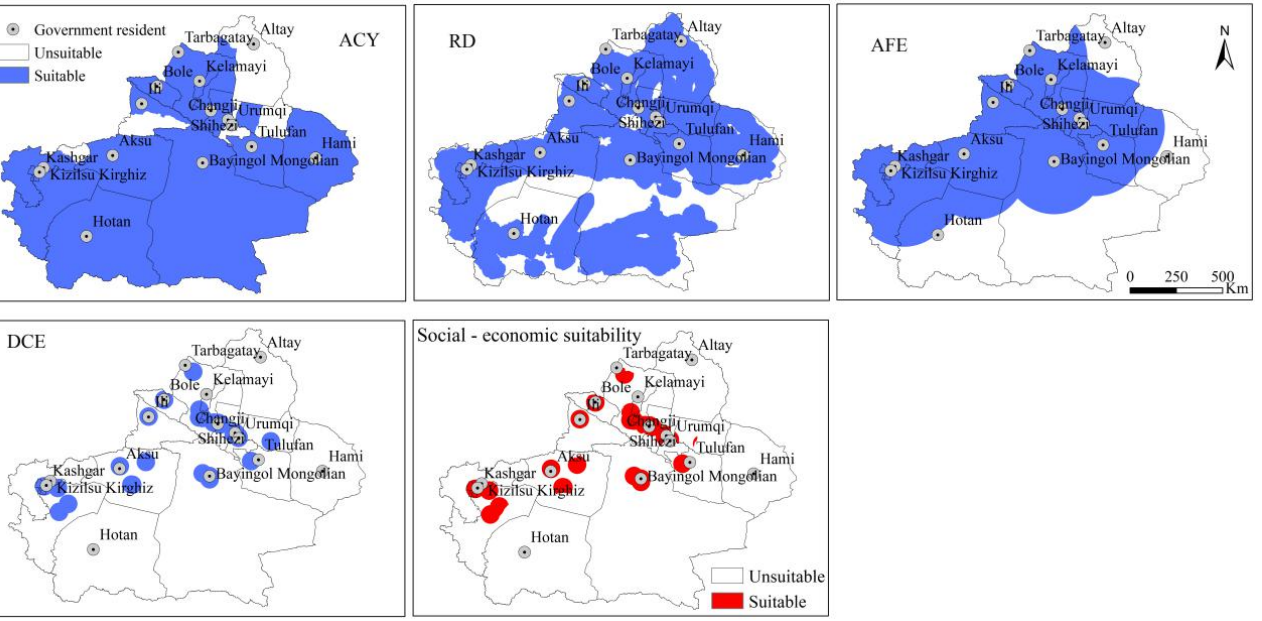
Figure 9. Suitable social and economic area for cotton seed production, ACY, the annual cotton yield; RD, road density; AFE, the accessibility of farmland to seed production enterprises; DCE, the density of cotton seed production enterprises.